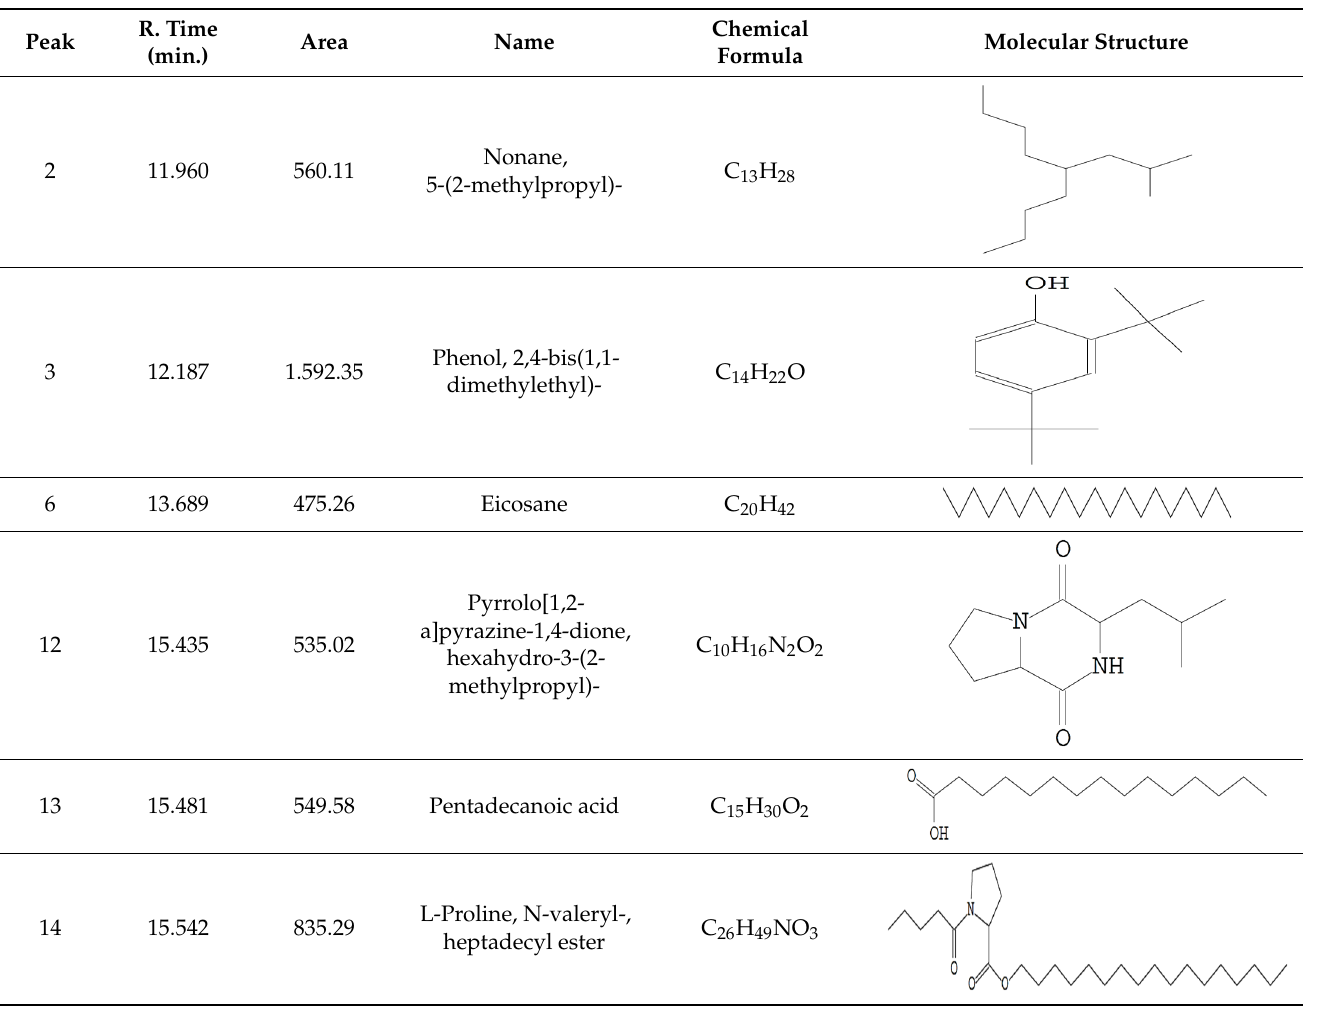
Table 3. The highest six compounds detected in HA1-CF as revealed with GC–MS analysis.